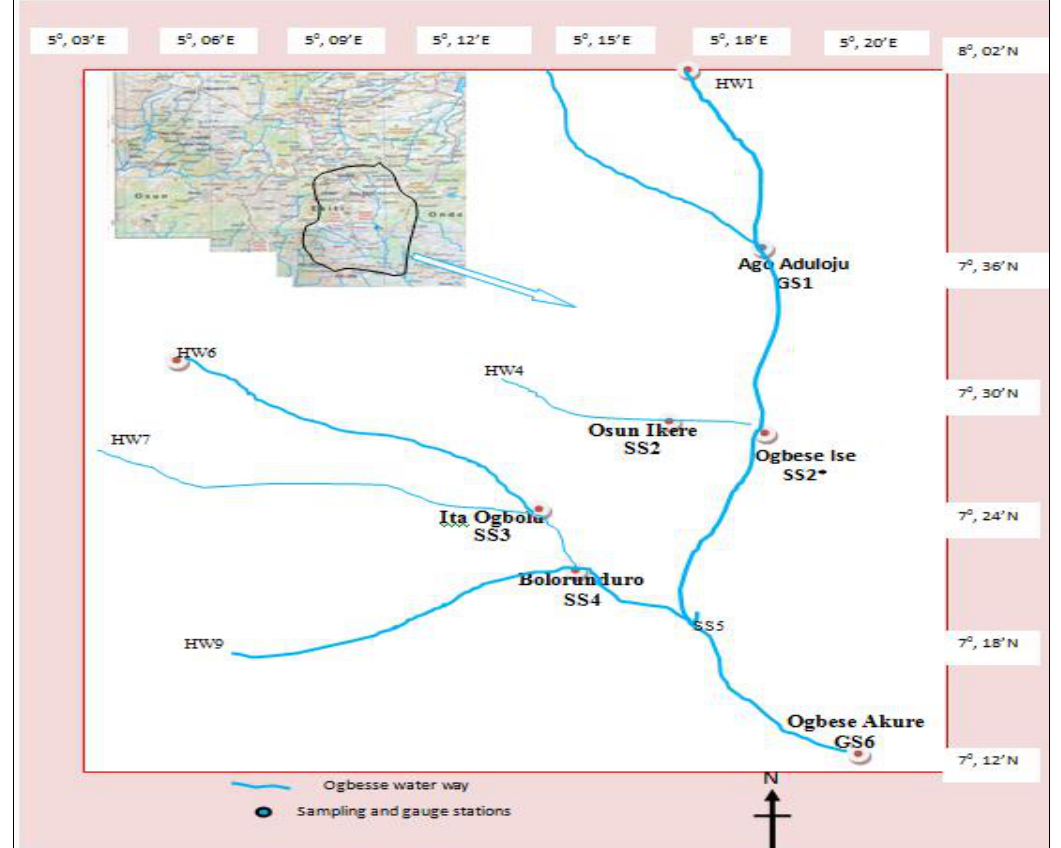
Figure 3: Extract from the Map of Nigeria showing drainage of the study área. Source: Authors, (2021).